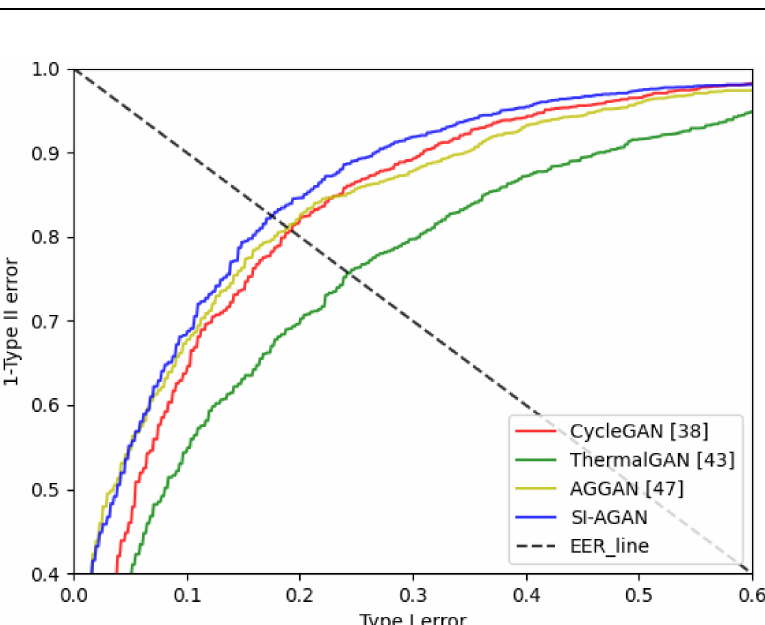
Figure 12. ROC curves of gender recognition accuracies with various style transfer